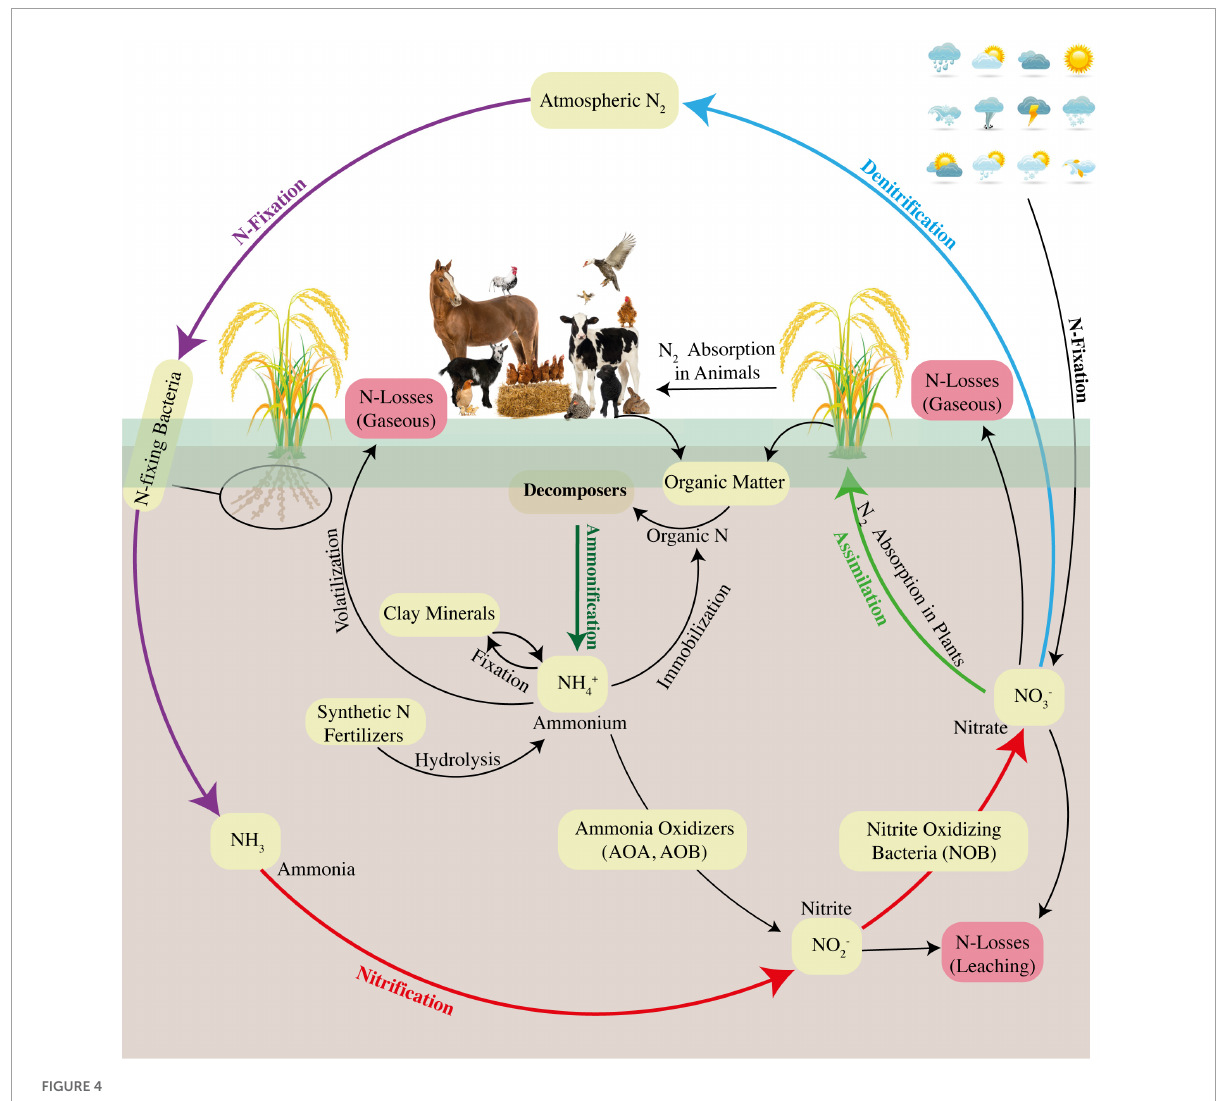
FIGURE4 Understanding the N dynamics and overviewing the pathways of the N cycle under the aerobic rice system (Farooq et al.,